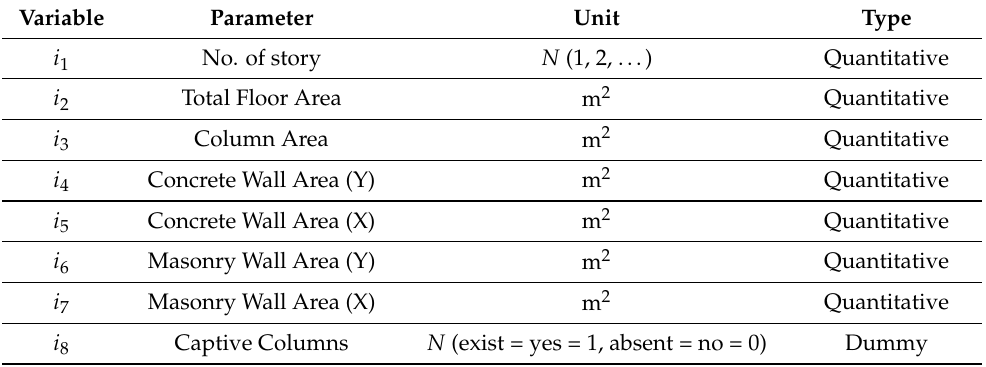
Table 1. Parameters for earthquake hazard safety assessment (adopted from